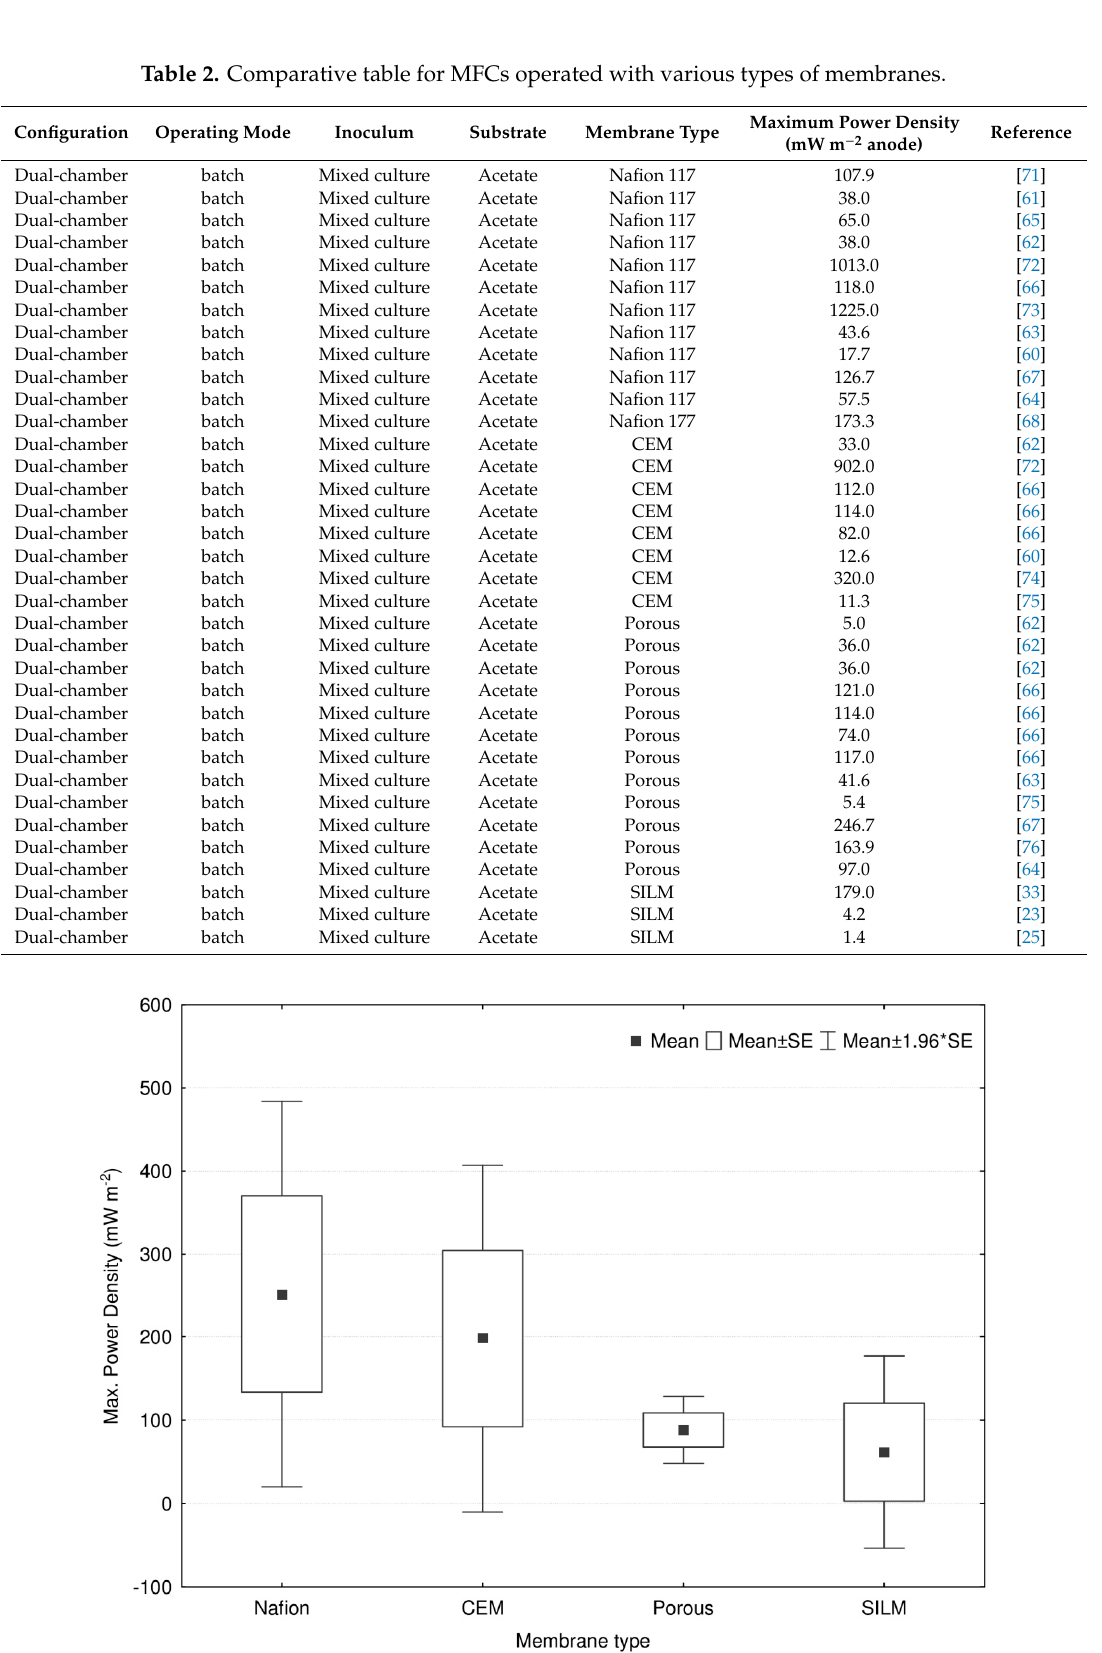
Figure 3. Illustrative comparison of MFCs based on the data of Table 2 with regard to the type of membrane used.